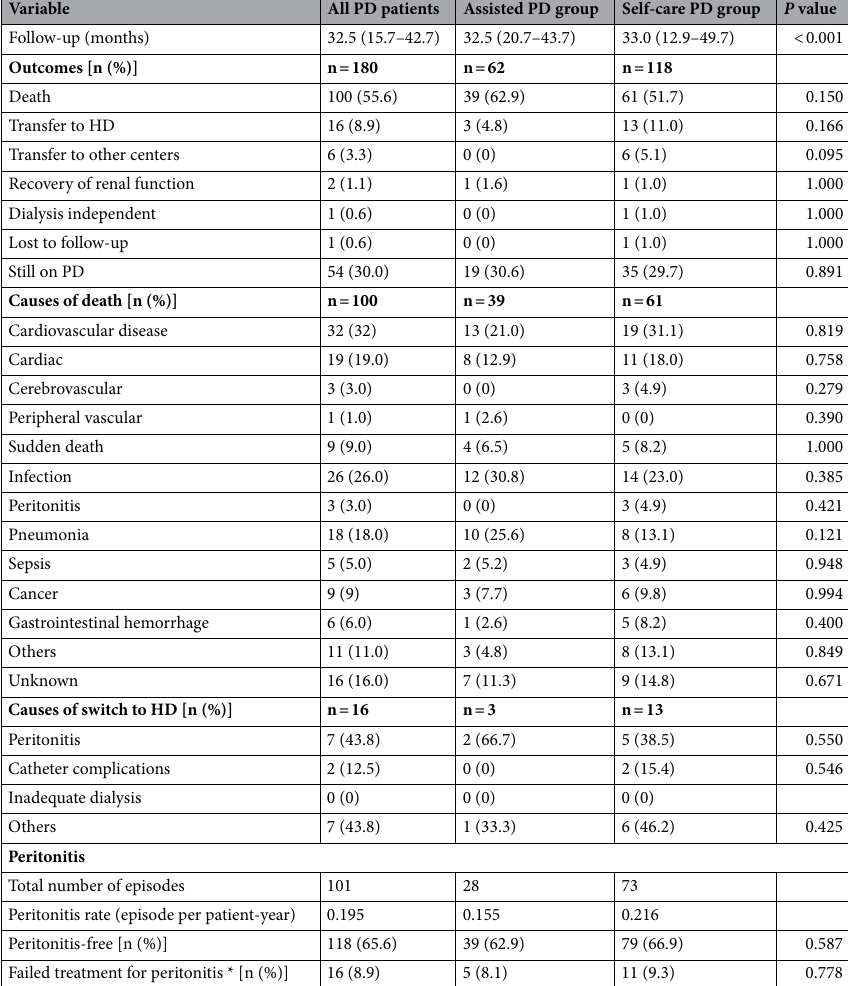
Table 3. Outcomes of the patients. Failed treatment for peritonitis* was defined as discontinuation of PD including temporary or permanent transfer to hemodialysis or peritonitis-related deaths; Peritonitis-related deaths included death directly caused by active peritonitis or within 4 weeks of a peritonitis episode, or any death during hospitalization for